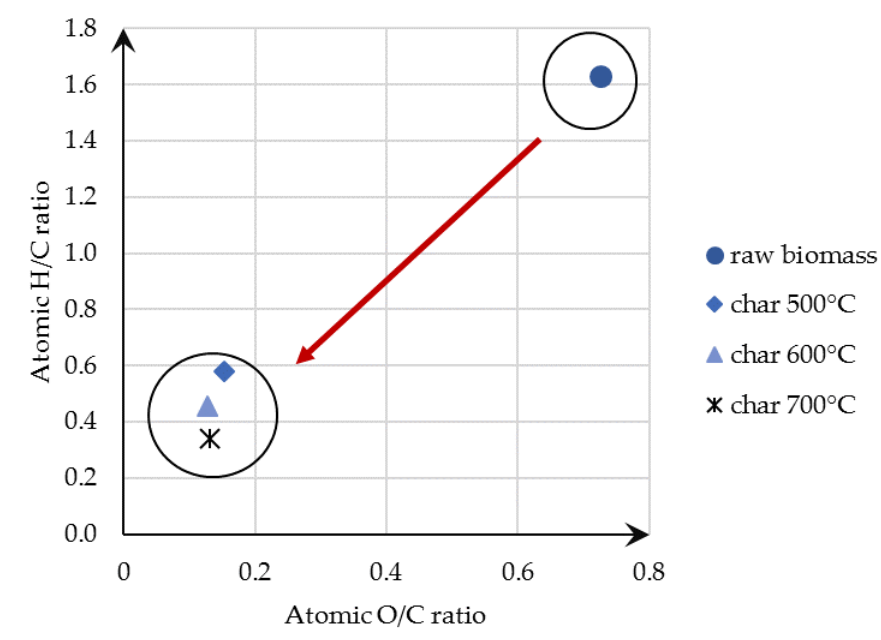
Figure 4. Van Krevelen chart for raw material and chars obtained at different temperatures.